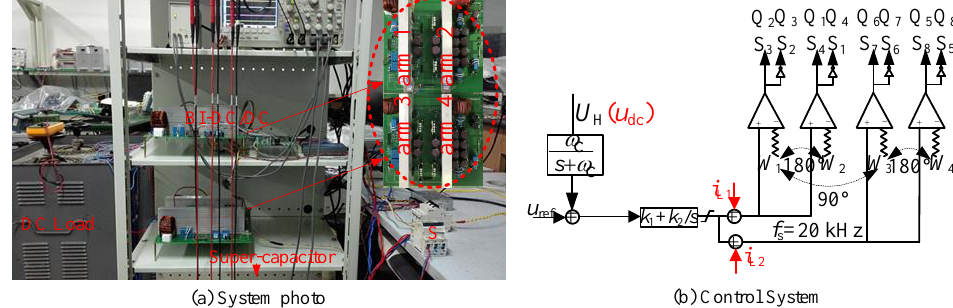
Figure 7. Experimental setup. ( a ) The experimental system, ( b ) Control system logic